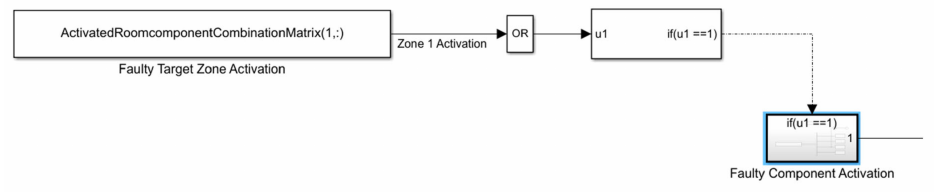
Figure 5. A view of faulty targeted FCR